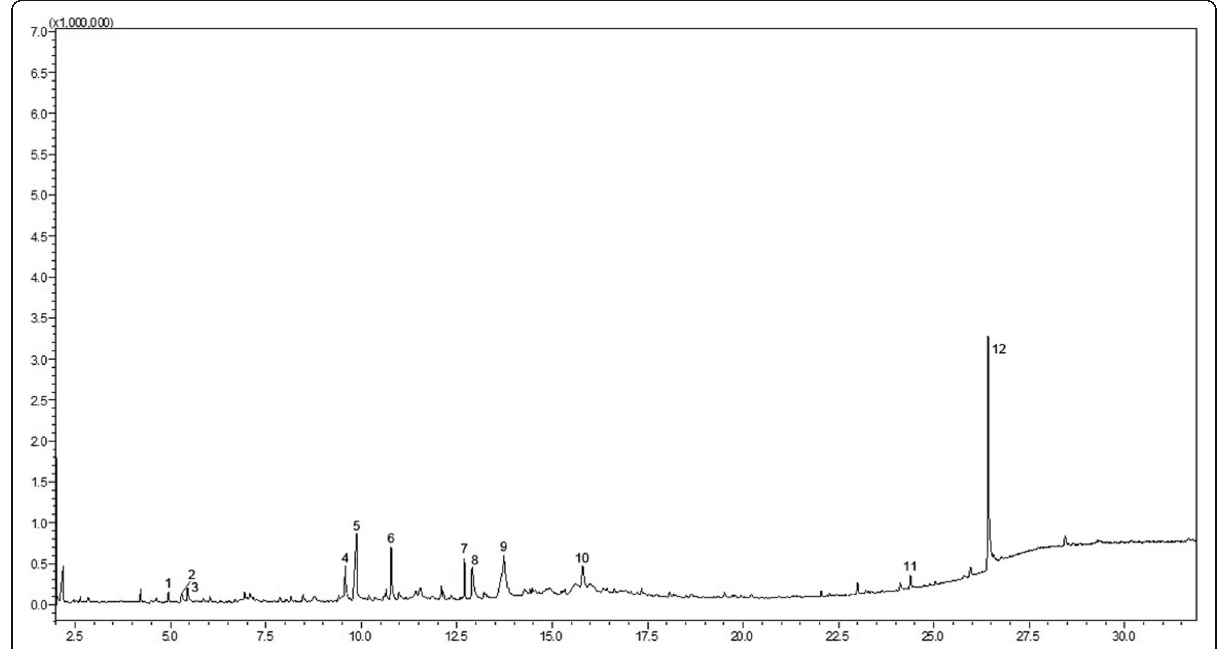
Fig. 11 GC-MS analyses of KD5040. The X-axis represents retention time, and the Y-axis represents